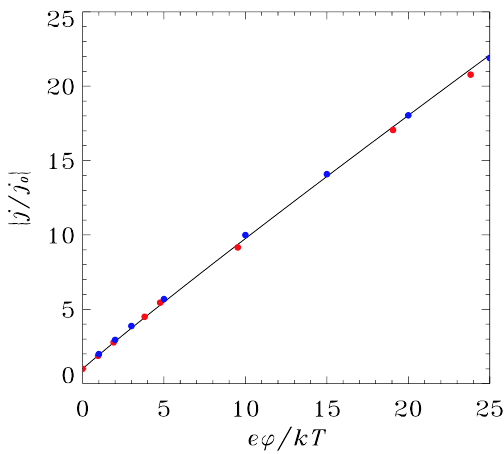
Fig. 5 Fig. 5. Normalised current as a function of normalised attractive potential of a spherical probe of radius r s =2cm in a non-flowing plasma with λ D = 2cm and T e = T i = 0 . 2 eV . Results of Lafram- boise (1966) are shown as blue dots, model results are shown as red b